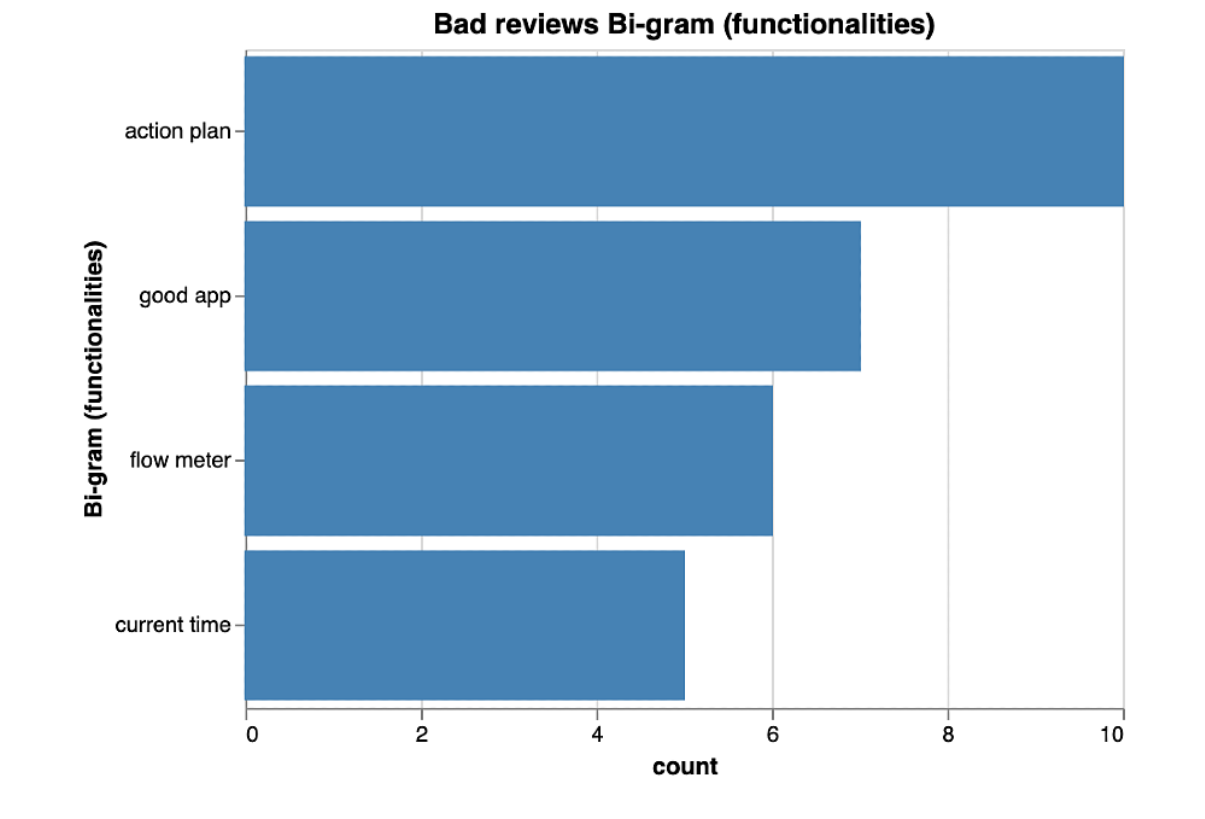
Figure 4. Bi-gram results of functionalities of poorly rated asthma mobile apps.